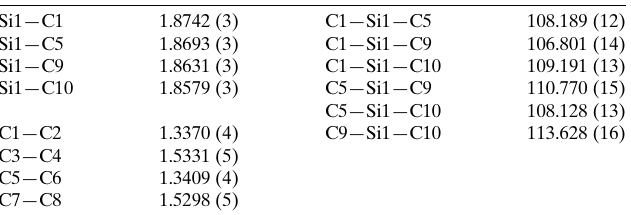
Table 1 Selected geometric parameters for compound 1 (A˚ , (cid:2) ).